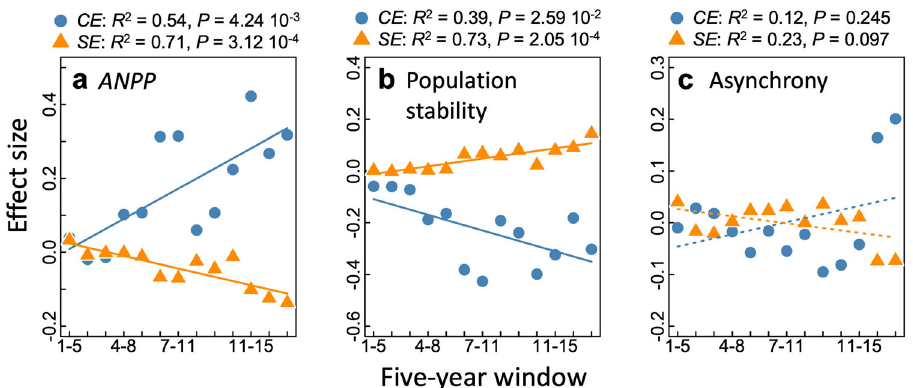
Fig. 5 | Indirect effects ofspecies richness on community stability through the 5-year complementarity (CE) and selection (SE) effects across 5-year rolling windows. a indirect effects through the CEand SEon community stability by their effects on ANPP (richness ->CE/SE ->ANPP ->population stability -> community stability), b bytheireffectsonpopulationstability(richness->CE/SE->population